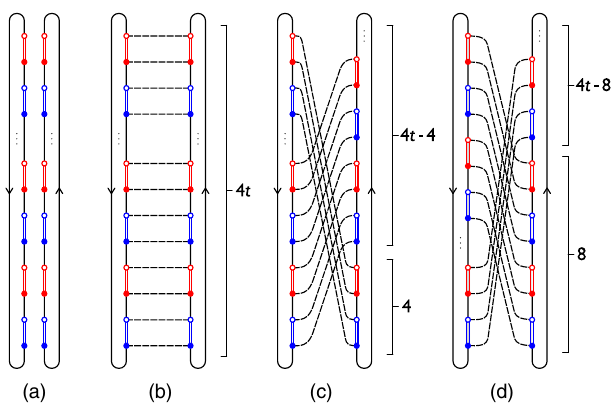
FIG. 7. (a) The site diagram associated with Tr ½ W ð t Þ(cid:2) Tr ½ W † ð t Þ(cid:2) . It is color coded as follows: For an odd site i , the blue dots and double lines are contributions from U i;i ones are from U i − 1 ;i or U † i − 1 ;i . For an even site, this coding is reversed. (b) – (d) Three examples from a total of t leading-order diagrams for K ð t Þ at t > 0